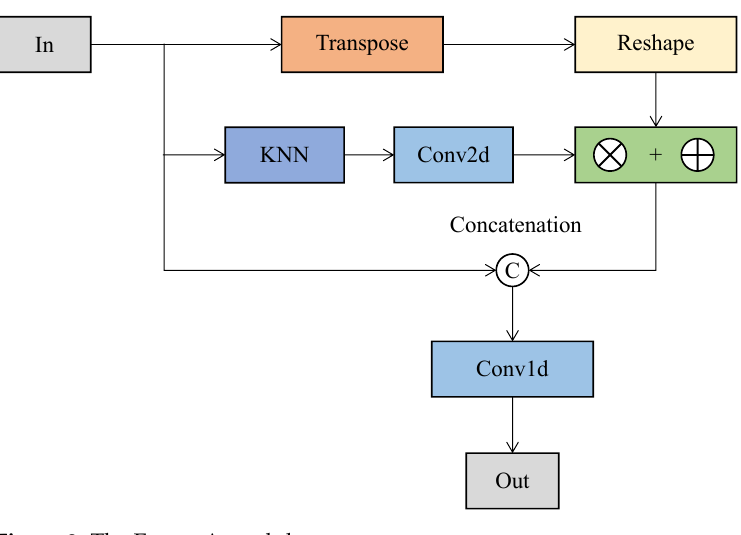
Figure 2. The ExtractA